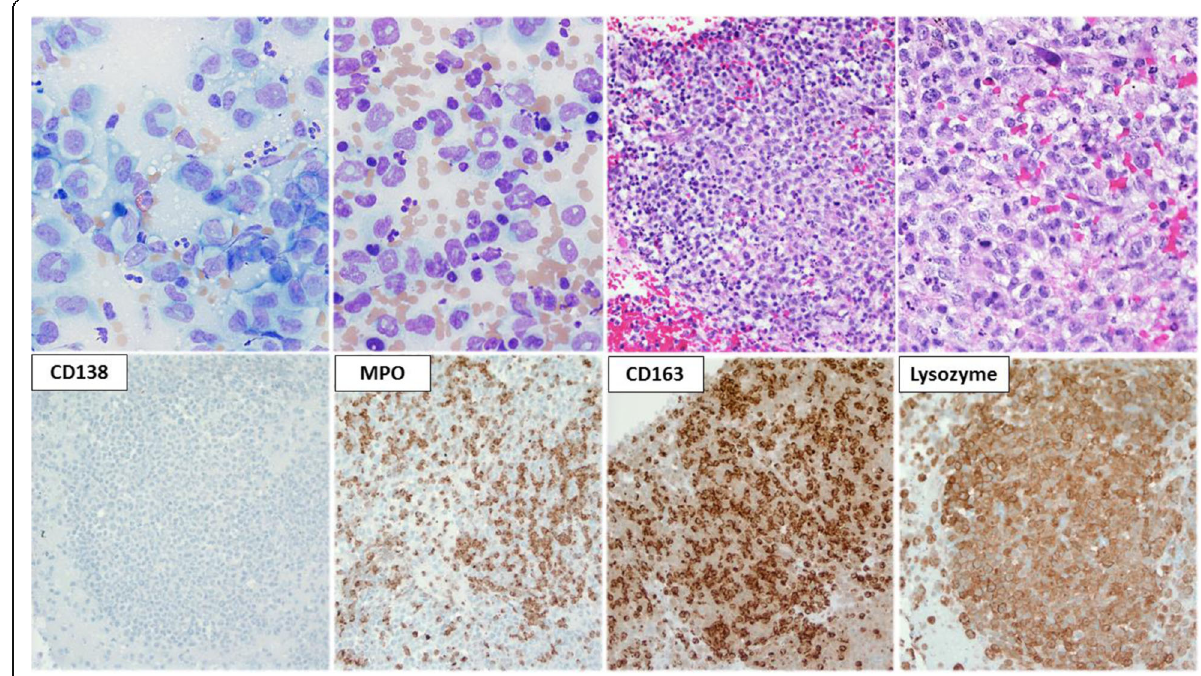
Fig. 3 Morphologic examination and immunohistochemical stains performed on the fine needle aspirate of the mediastinal lymph node. The Diff-Quik ™ stained slides show large monocytoid cells with ample blue-grey cytoplasm, round to irregular nuclear contours and immature chromatin (× 500, top-left). The H&E stained sections prepared from the cell block shows a diffuse infiltrate of monocytoid cells with ample cytoplasm and round to irregular nuclear contours (× 200 and × 400, top-right). The tumor cells were negative for CD138 and positive for